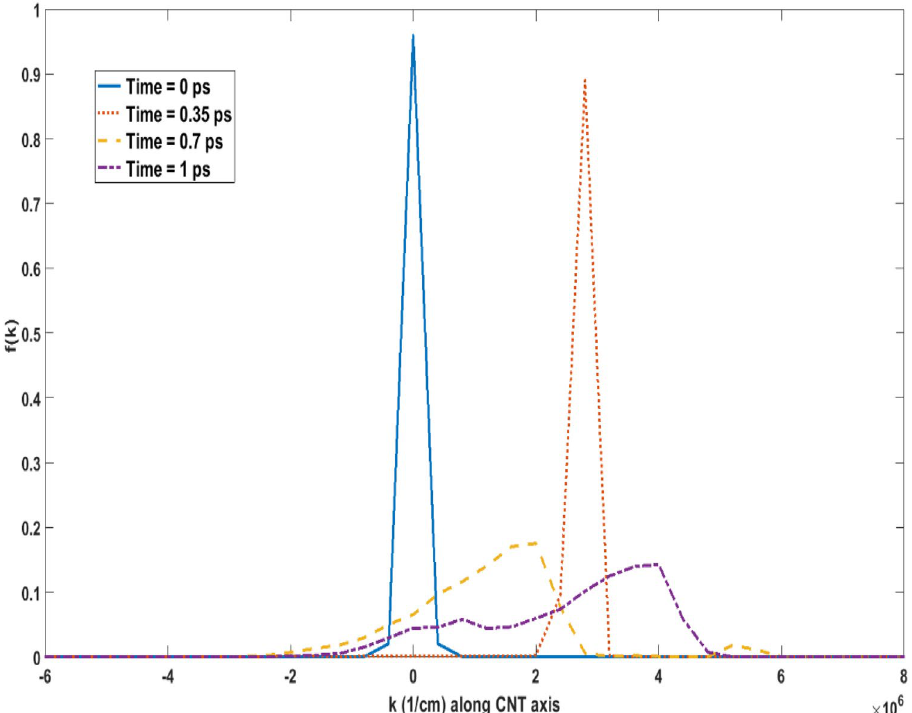
Figure 3. Transient time evolution of the electron distribution function for a 5 kV/cm electric field at 4 K for (49,0) CNT. The electron distribution is seen to be significantly affected by the first set of emission scattering peaks around k = 4 × 10 6 /cm seen in Fig. 2. Please note that the distribution at t = 0 is a thermal equilibrium Gaussian distribution that appears as a sharp peak in the k -axis scale